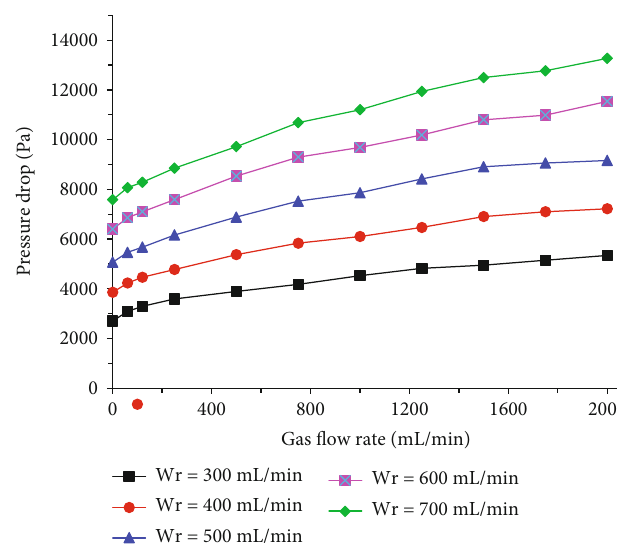
Figure 5: Evolution of the two-phase pressure drop with respect to the water fl ow rate and gas fl ow rate in case